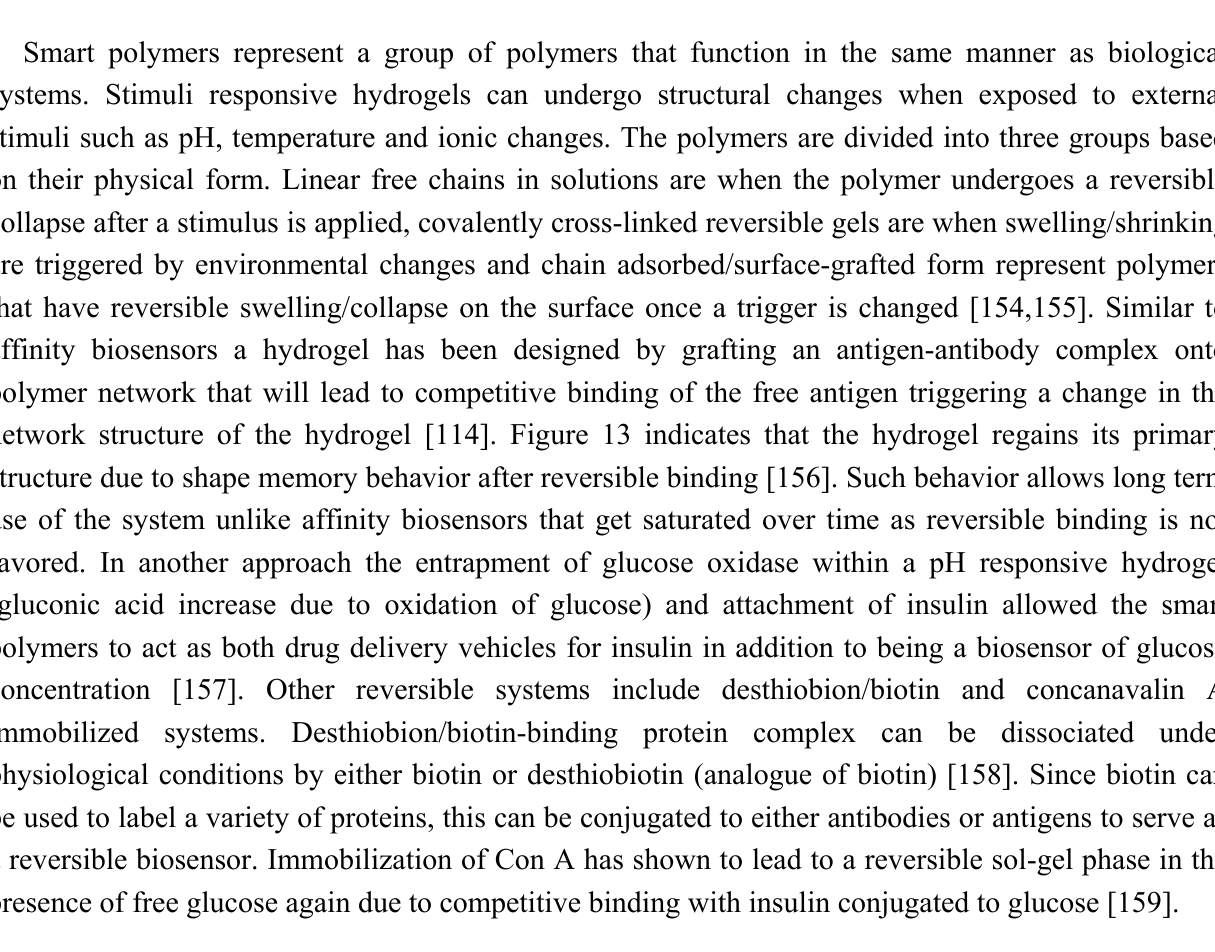
Figure 13. Reversible antigen responsive hydrogel (adapted from